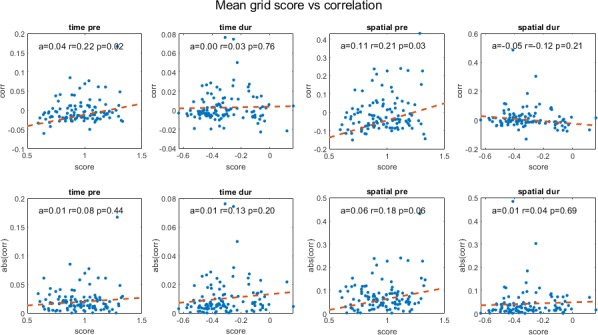
Temporal and spatial correlations for cell pairs in cohort pre- and during inactivation plotted against their average grid score, including slope of the regression line (a), correlation coefficient (r) and p-value (p).The second row shows the same plots for absolute correlation values.